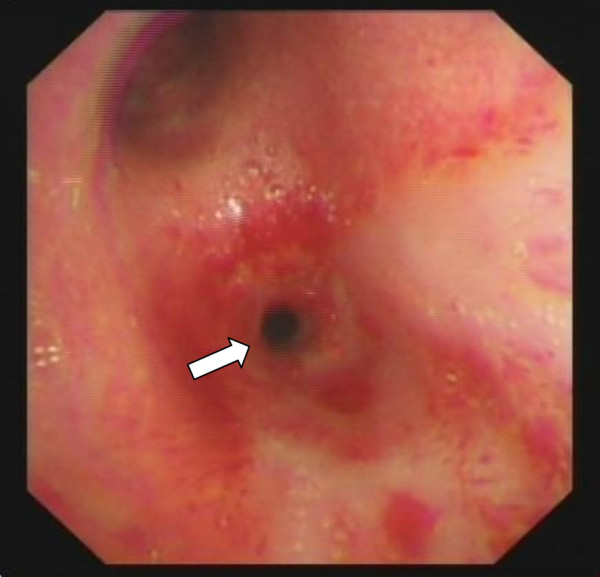
The intermedial segment bronchus was in severe stenosis with a diameter of approximately 3mm before dilation (arrow). (2 November 2011).